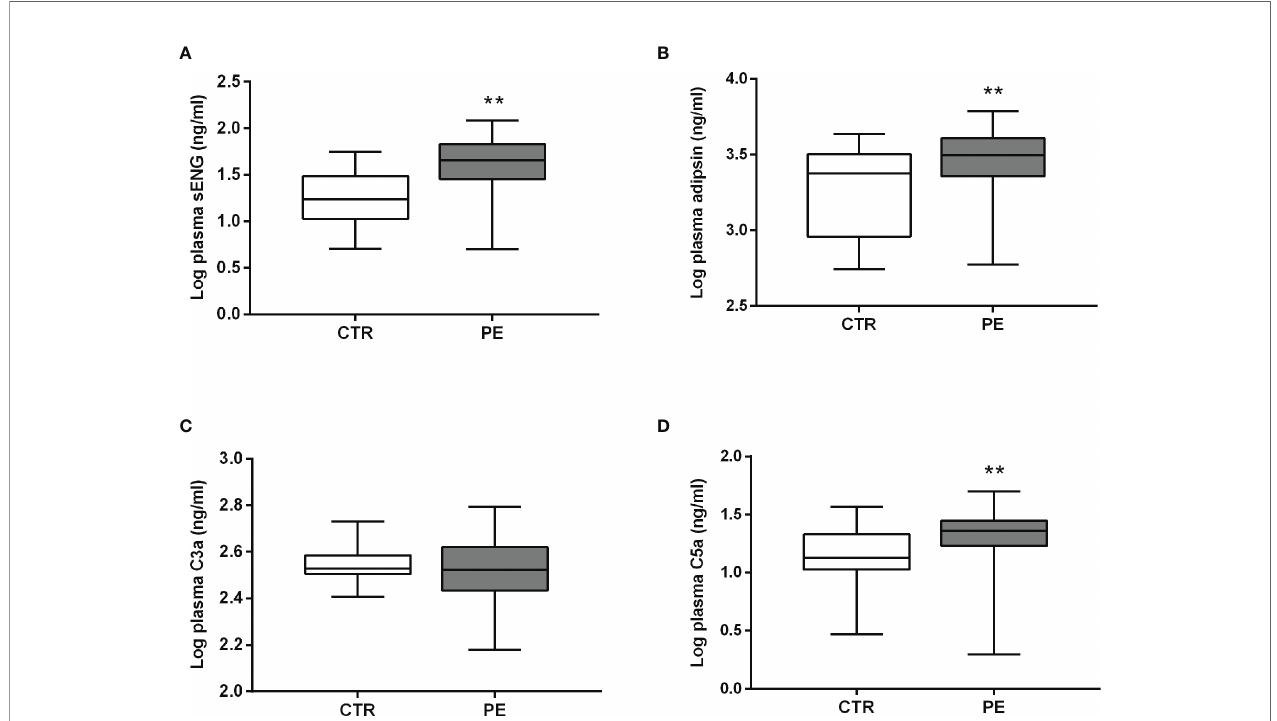
FIGURE 1 | Plasma levels of sENG, adipsin, C3a, and C5a before delivery. Levels of sENG (A) , adipsin (B) , C3a (C) , and C5a (D) in the plasma of healthy (white, n = 32) and preeclampsia (gray, n = 33) populations as measured using ELISA. ** P < 0.01 vs . healthy pregnant women.